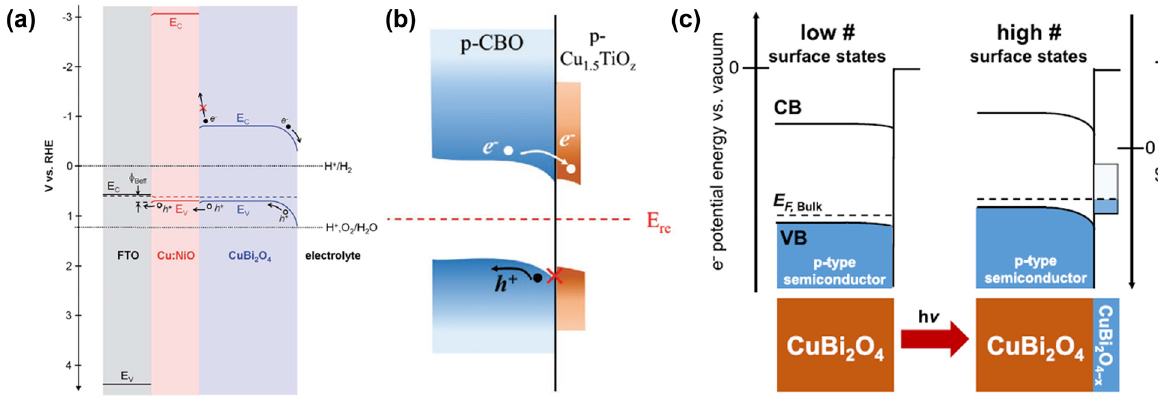
Figure 10: ( a ) The favorable alignment of the energy levels of FTO/Cu:NiO/CuBi 2 O 4 facilitates hole transport to FTO, while blocking electrons from reaching FTO. ( Reprinted from ref. [ 180 ]) . ( b ) Band alignment of CuBi 2 O 4 /Cu 1.5 TiO z interface, showing favorable electron transport to the overlayer. ( Reprinted with permission from ref. [ 175 ] . Copyright © 2020, John Wiley and Sons ) . ( c ) Introduction of surface states on CuBi 2 O 4 upon irradiation resulted in a shift in Fermi level and an increased band bending. ( Reprinted from ref. [ 182